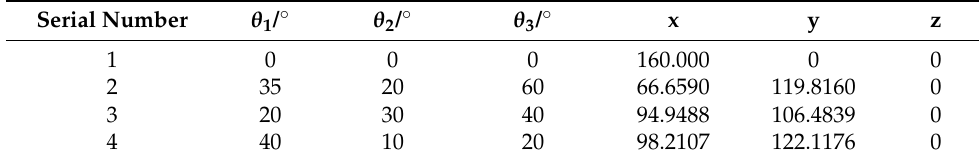
Table 1. Experimental data and calculation results for joint rotation angle.